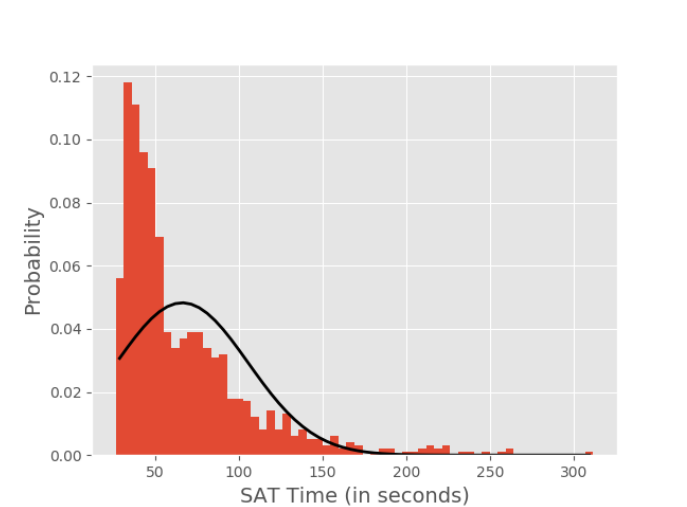
Figure 3: Histogram of the SAT solver